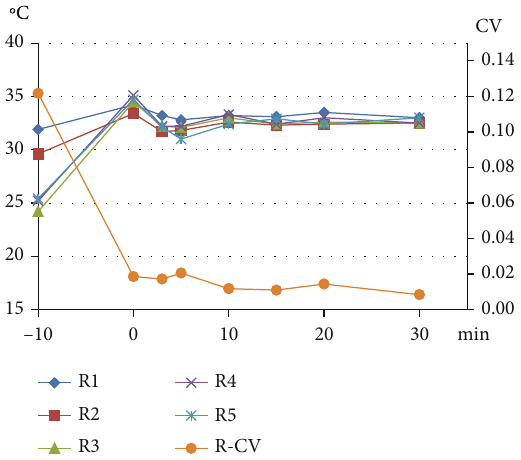
Figure 1: Time-course changes in Temp of each fi nger of the right hand (R1 – 5), before and after CO bathing, in a 59-year-old female 2 patient with Raynaud disease. Change in CV is also plotted. Temp: nailfold temperature; CV: coe ffi cient of